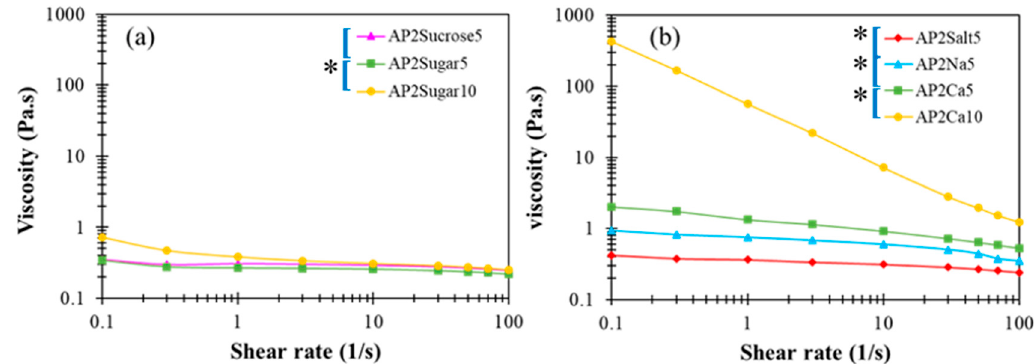
Figure 6. Steady-state viscosity profiles as a function of shear rate for AP-based matrices with ( a ) sugar incorporation and, ( b ) cations at either 5 or 10 % concentrations; the indicated left brackets ([) marked on sample labels are significantly different from each other at the 5% level by a paired t -test; the indicated left brackets with an additional star (*[) marked on sample labels are significantly different from each other at the 1% level by a paired t -test.